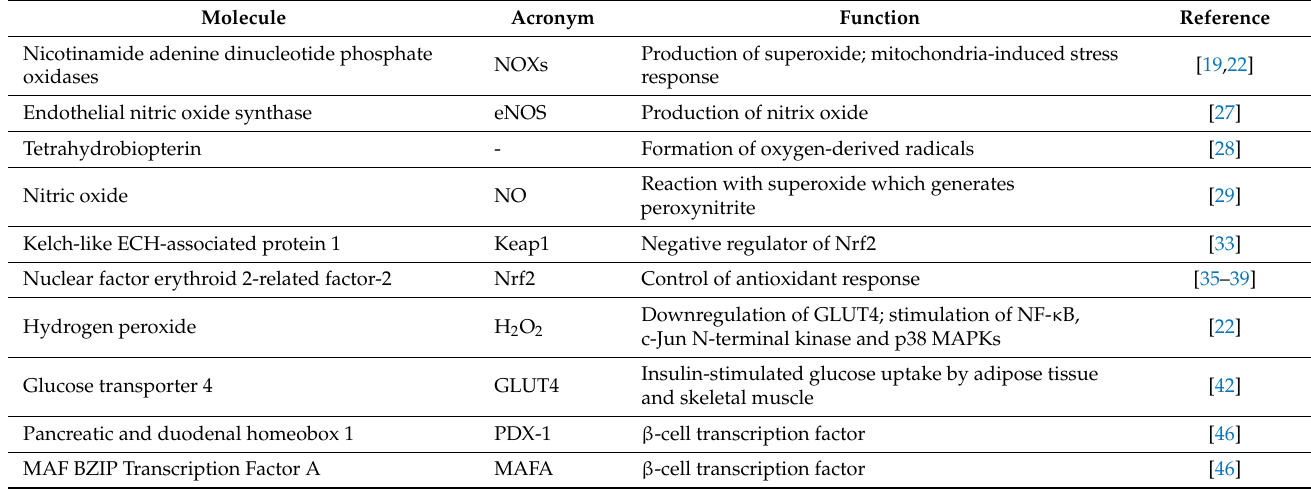
Table 1. List of main molecules involved in the onset of insulin resistance and type 2